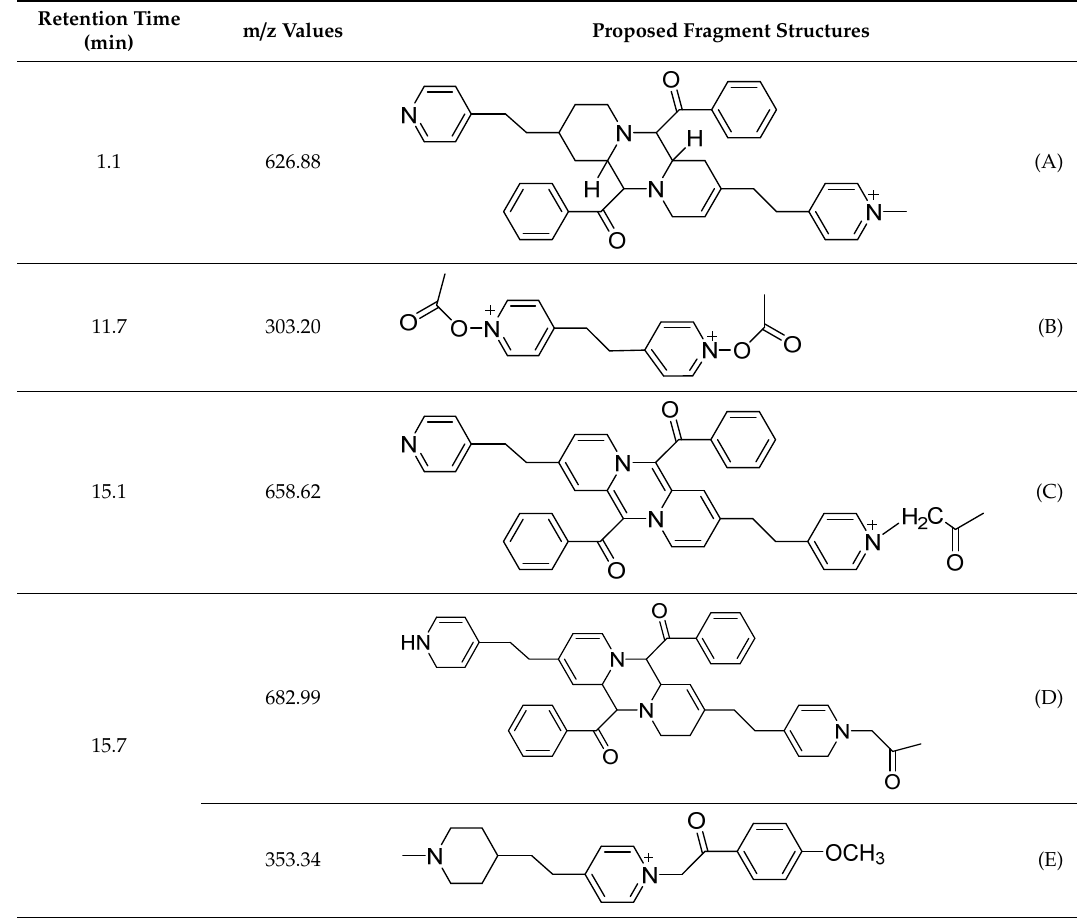
Table 5. Retention times, m / z values of the prominent ions from the mass spectra of supernatant Table 5. Retention times, m/z values of the prominent ions from the mass spectra of supernatant Table 5. Retention times, m/z values of the prominent ions from the mass spectra of supernatant solution, and the corresponding fragment structures of the fluorescent species. Table 5. Retention times, m/z values of the prominent ions from the mass spectra of supernatant solution, and the corresponding fragment structures of the fluorescent species Table 5. Retention times, m/z values of the prominent ions from the mass spectra of supernatant solution, and the corresponding fragment structures of the fluorescent species Table 5. Retention times, m/z values of the prominent ions from the mass spectra of supernatant solution, and the corresponding fragment structures of the fluorescent species solution, and the corresponding fragment structures of the fluorescent species solution, and the corresponding fragment structures of the fluorescent Retention Time Retention Time Retention Time